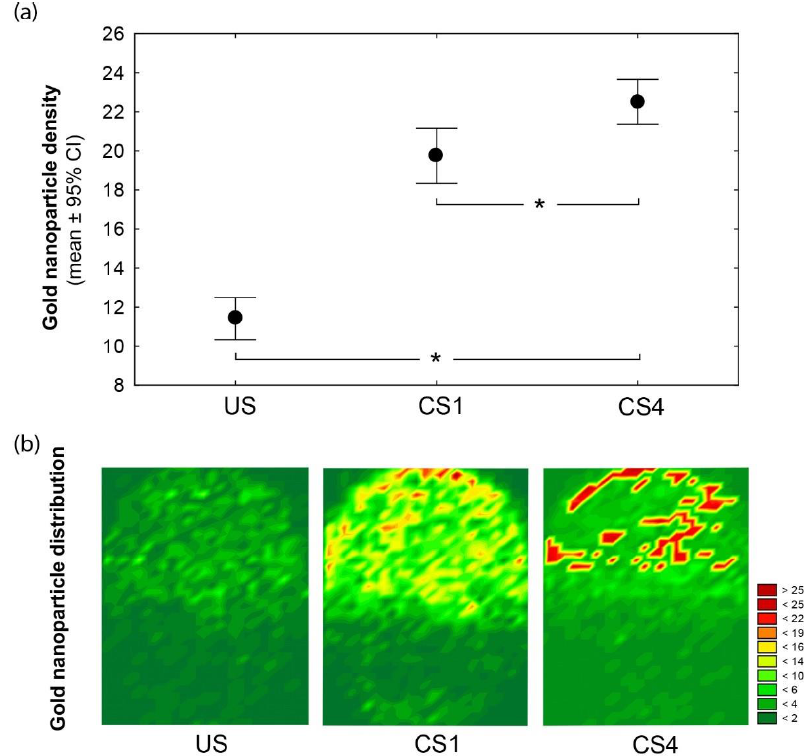
Figure 2. ( a ) The gold nanoparticle density and distribution differ among head spermatozoa according to the time-de- pendent capacitation conditions: uncapacitated (US), one- (CS1), and four-hour-capacitated (CS4) spermatozoa. Mean (dot) and whiskers denote ±95% confidence intervals (CI). Significant differences between the physiological conditions (Kruskal-Wallis at p < 0.05) are indicated (*). ( b ) Wafer maps illustrating the arylsulfatase A (ARSA) redistribution before (US) and after (CS1−4) spermatozoa capacitation. Topographic views denote the superposition of nanoparticle counts and their Cartesian spatial distributions from the labeled spermatozoa of each condition. The color scale indicates the nano- particle count.